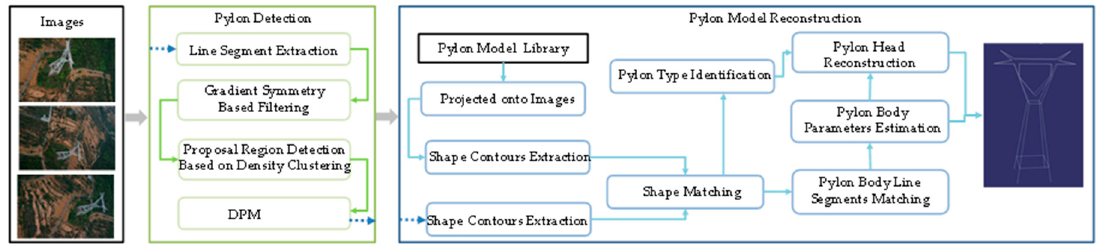
Figure 1. The workflow of proposed method.